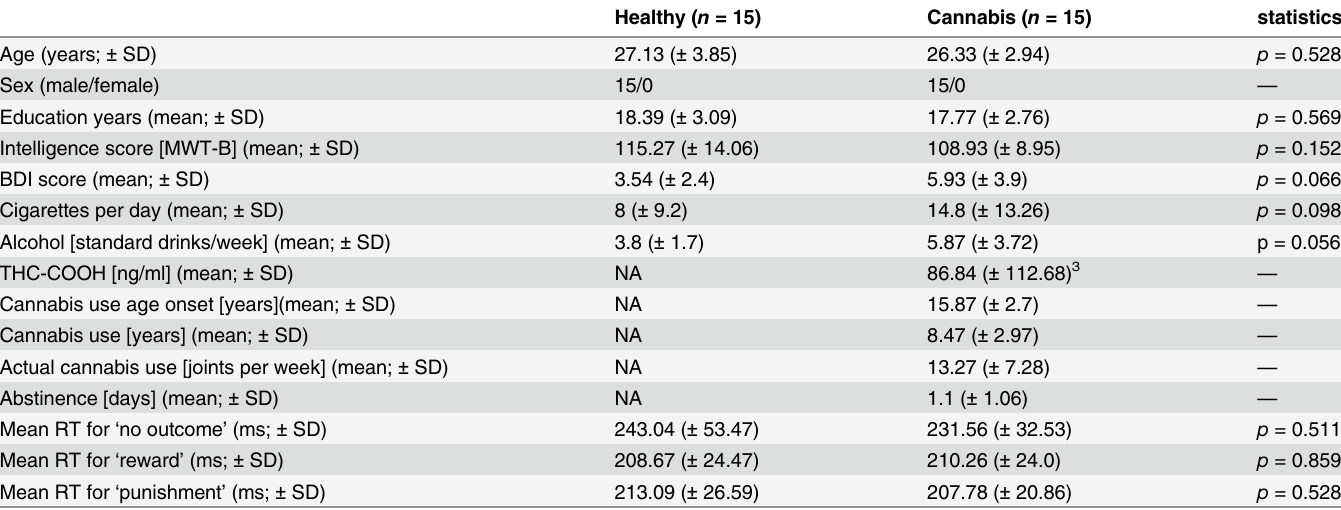
Table 1. Characteristics of healthy controls and cannabis misuse